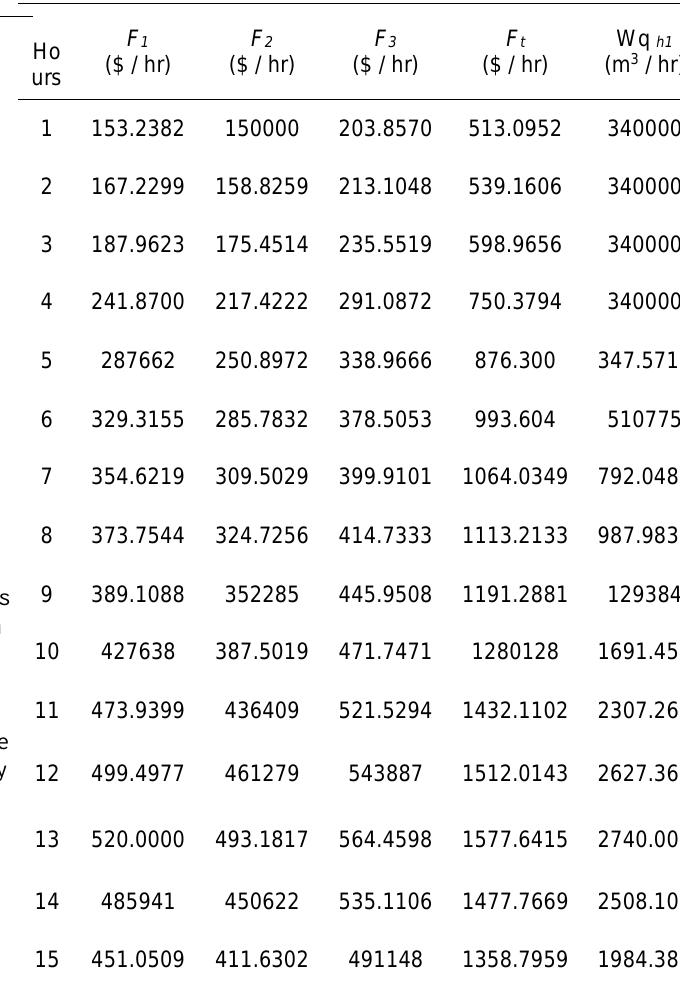
Table 5. Generation cost for thermal and hydro plants over hourly planning